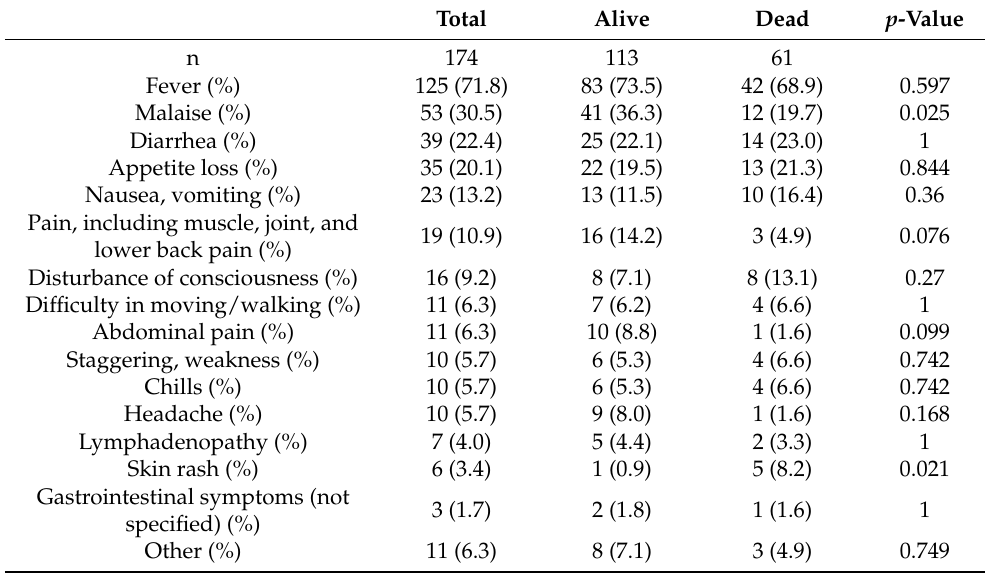
Table 2. Chief complaints among patients diagnosed with